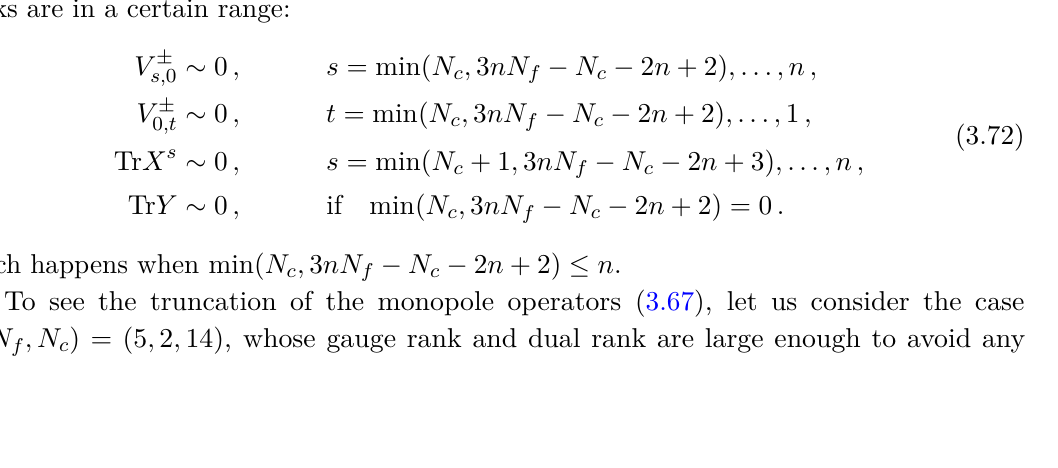
Table 8 . The superconformal index results for the double adjoint theories with ∆ W A = W + Here we list a few examples with ( n, N those with ( n, N